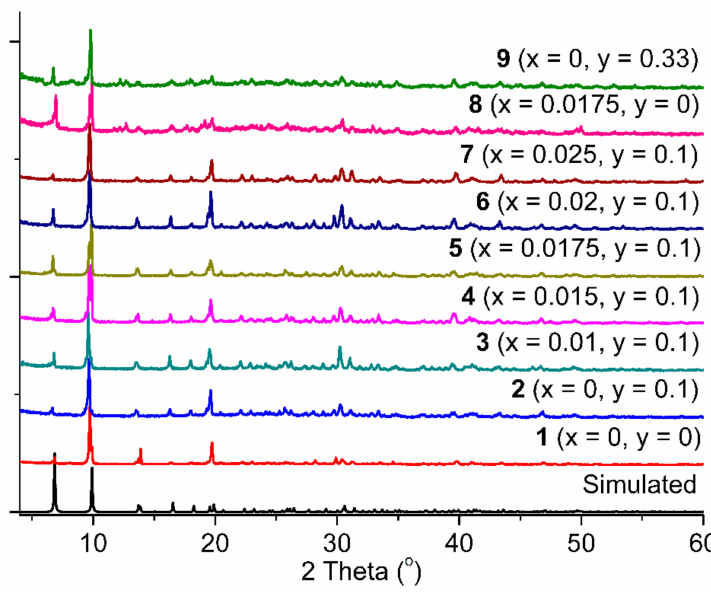
Figure 2. Powder X-ray di ff raction paterns of the doped analogues 1 – 9 with the general formula [La 1 − x Eu x (bpdc) 1 − y (dabpdc) y Cl(DMF)]; the values of x and y corresponding to each doped analogue are shown on the